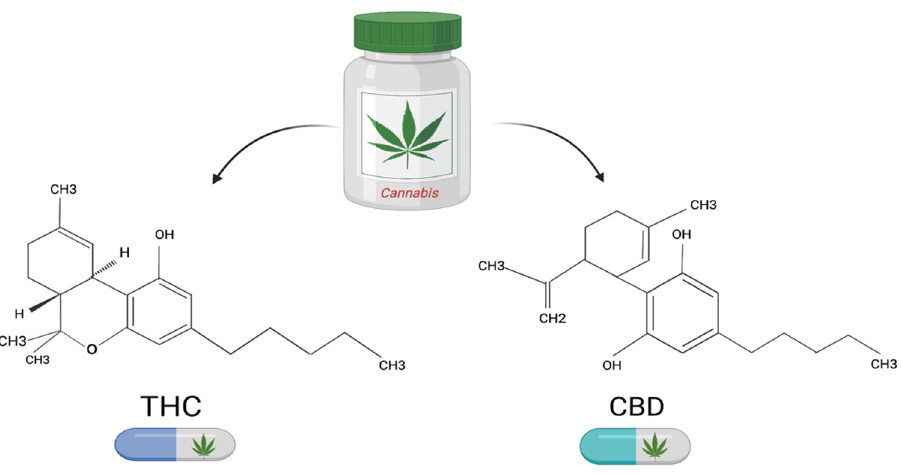
Figure 1. The main constituents of Cannabis sp. and their molecular formulas. CB1 receptors are primarily expressed in the peripheral and central nervous systems, while CB2 receptors are highly expressed in the immune system. Both CB1 and CB2 receptors are negatively correlated with adenylate cyclase activity